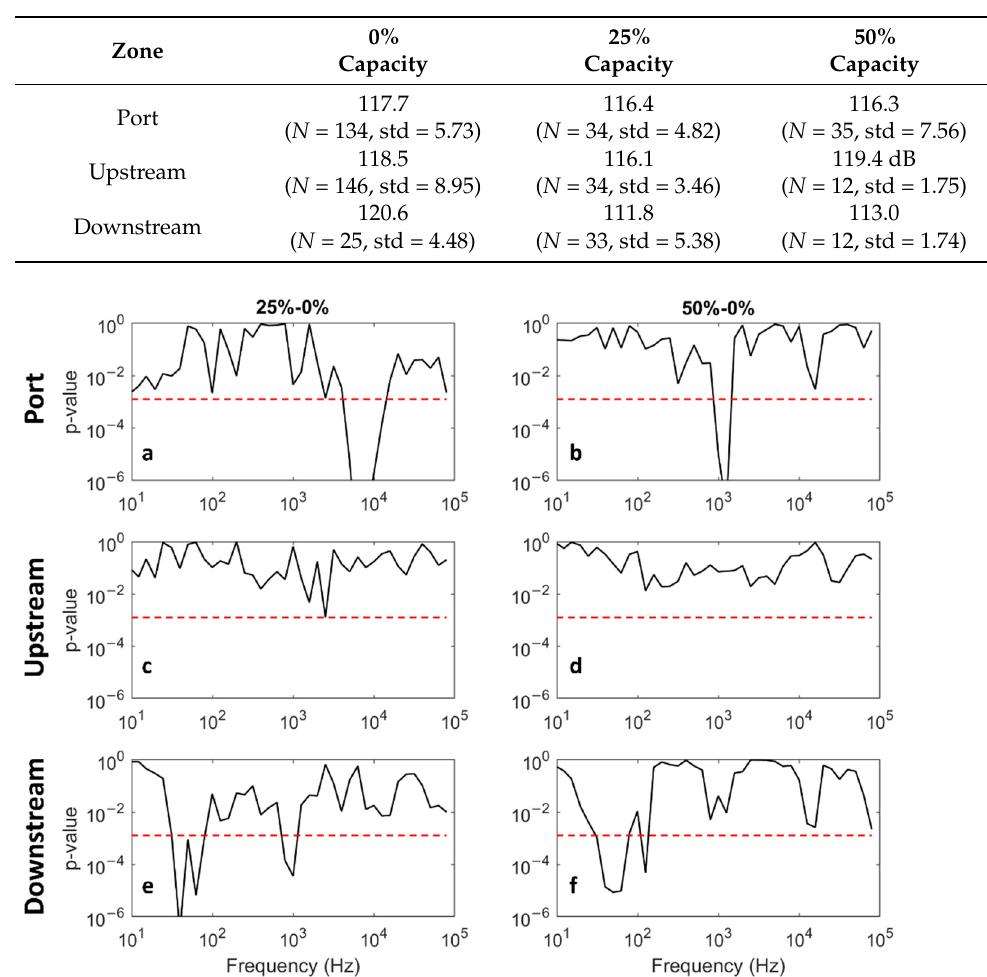
Table 1. The median and standard deviation values (in brackets) of the sound pressure levels in each measurement zone as a function of rated capacity (0%, 25%, 50%, within ± 10% for the average capacity of samples included in the bin). No data points met the 75% or 100% capacity level in any of the assessment zones. N is the number of samples in each zone and capacity range. Units are in dB ref 1 µ Pa.